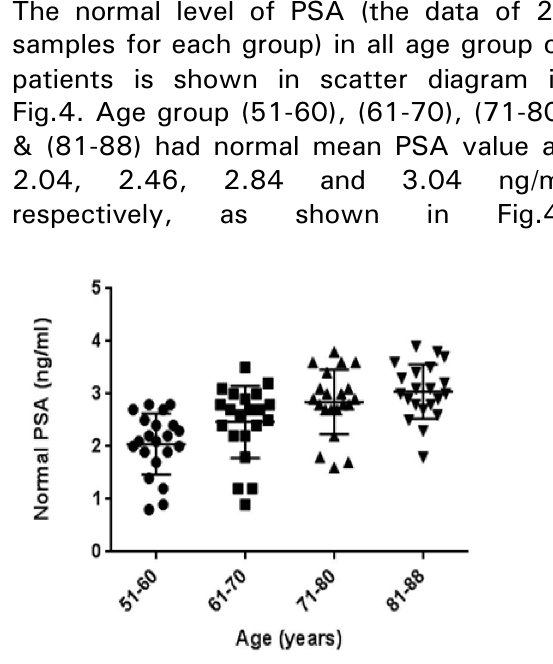
Figure 4. Normal level of PSA in patients of different age group PSA level was estimated by the blood samples of patients of all age group. Normal level of PSA in the different patients of all respective age group. (The data of 20 samples of each group is